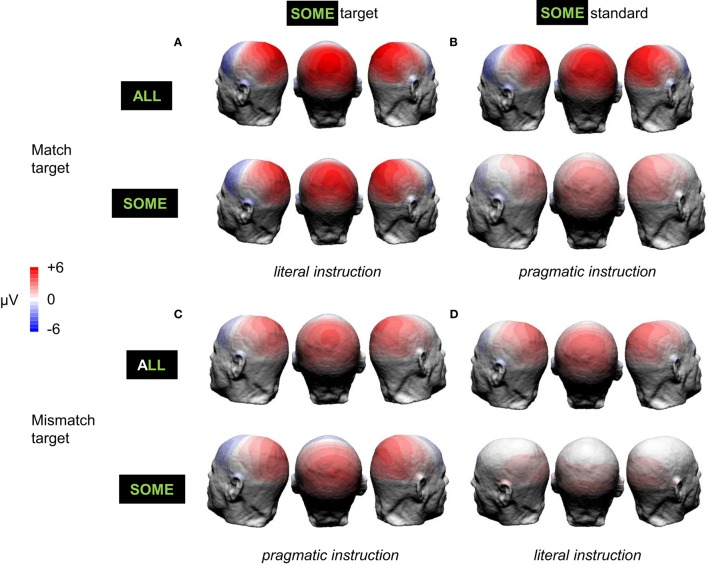
P3b effect topographies elicited by target-ALL and ambiguous-SOME in match target (A,B, 440–590 ms) and mismatch target (C,D, 550–700 ms) blocks. (A,C) ambiguous-SOME as target; (B,D) ambiguous-SOME as standard. In italics: the context of interpretation of ambiguous-SOME.